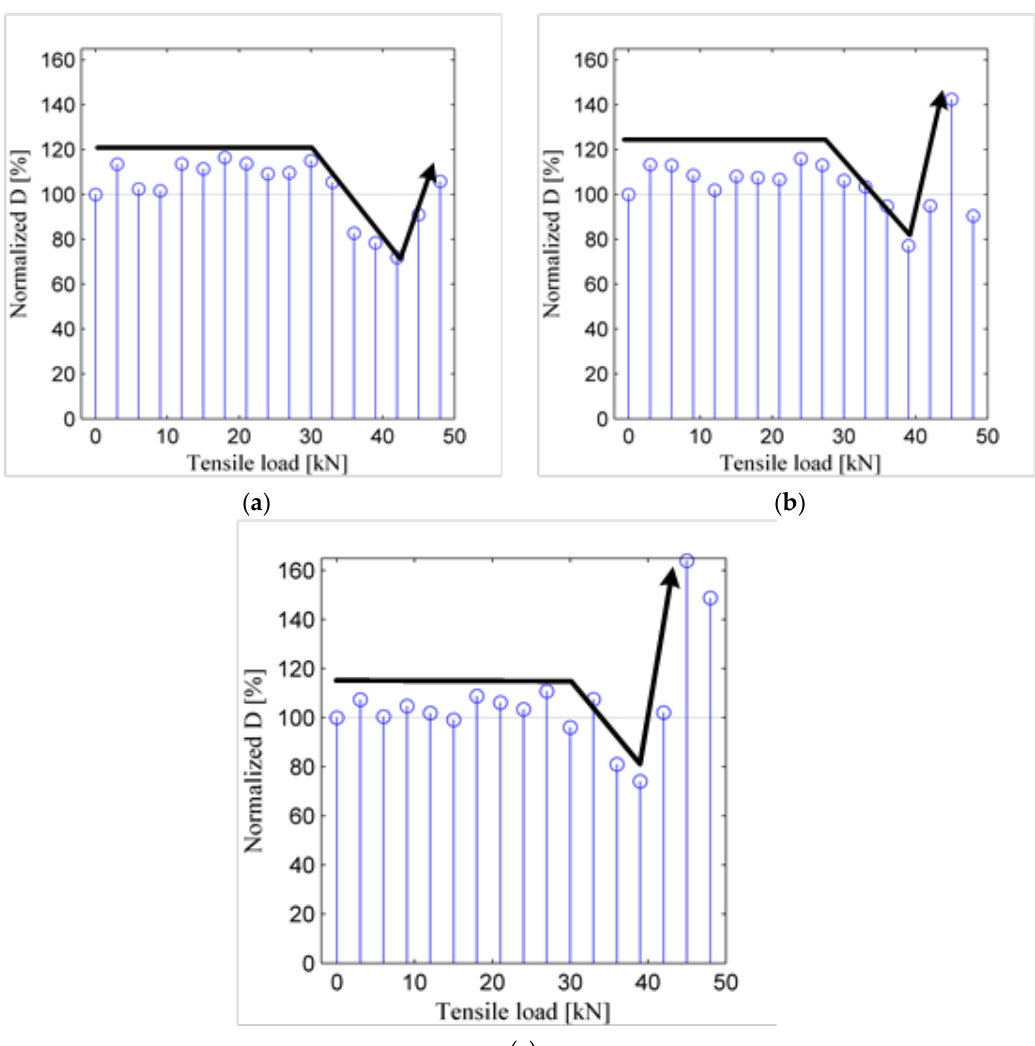
Figure 9. Normalized ultrasonic energy coefficients of three samples under tensile forces: ( a ) Sample L1; ( b ) Sample L2; ( c ) Sample L3.